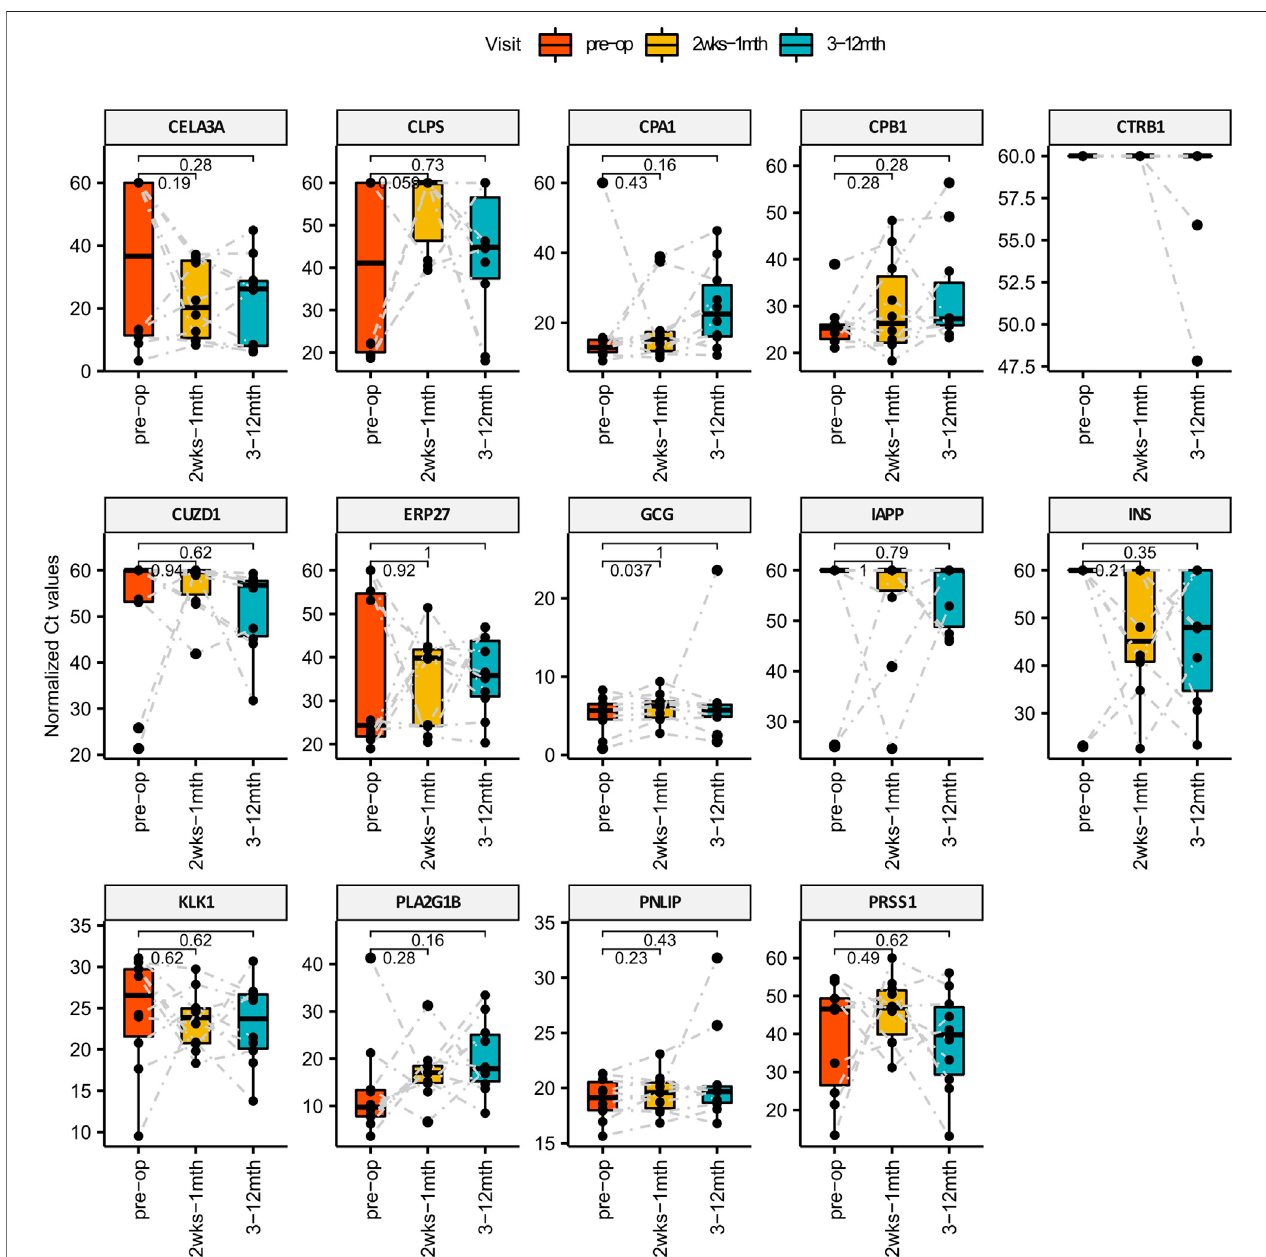
FIGURE2| BarChartscomparingthelevelsofpancreatic speci fi ctranscripts acrossdifferentvisitpost-surgery. X -axisrepresents thedifferenttime pointsand the Y -axis is the normalized Ct value of the cfmRNA. Wilcox paired test is used for statistically comparing the short and long term levels of cfmRNA against the pre-surgery measurements. GCG cfmRNA Ct measurements was identi fi ed to be statistically signi fi cant higher in the short term post-surgery which translates to a lower quantity of GCG cfmRNA in circulation immediately after bariatric surgery.